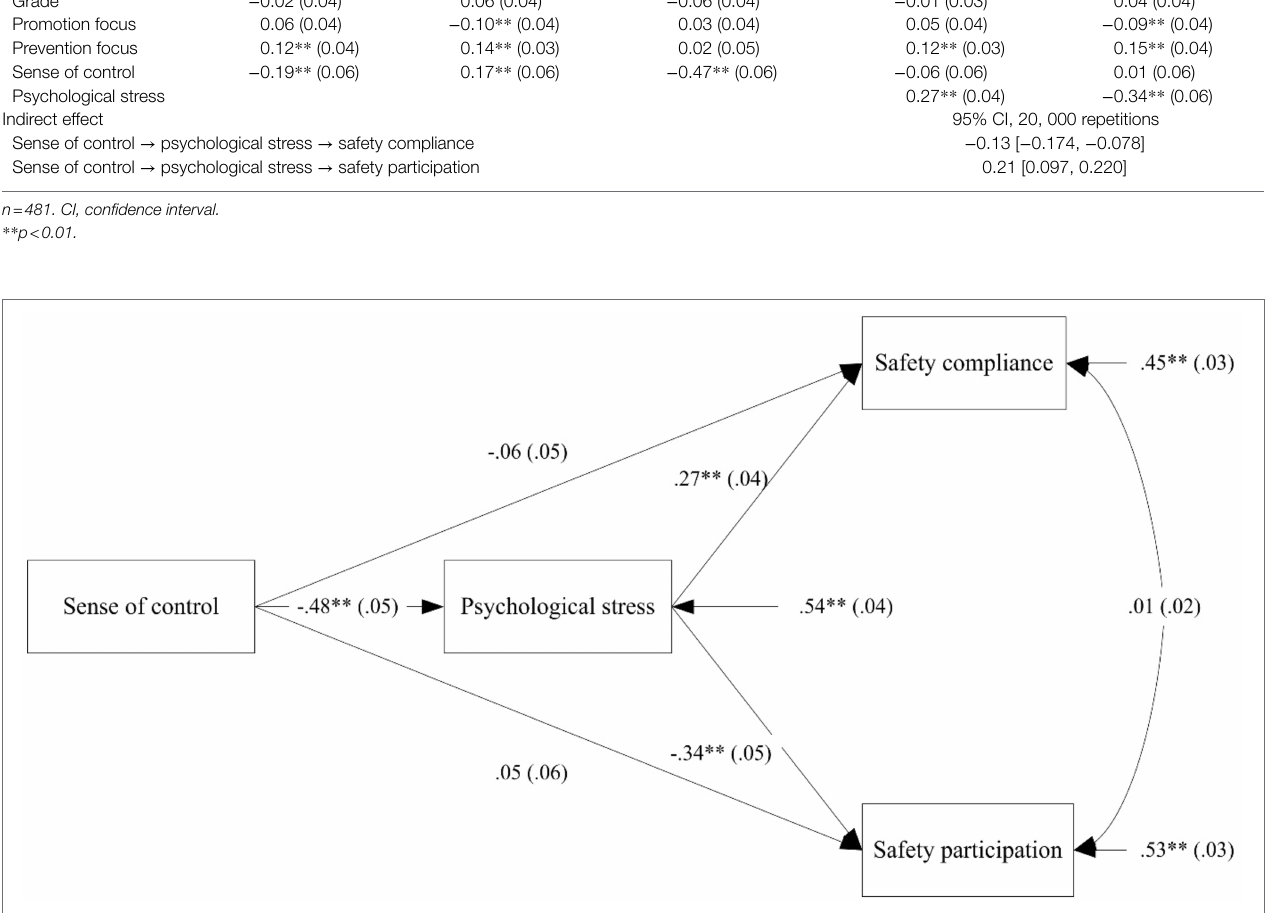
FIGURE 2 | Path analysis of research model. ** p < 0.01,